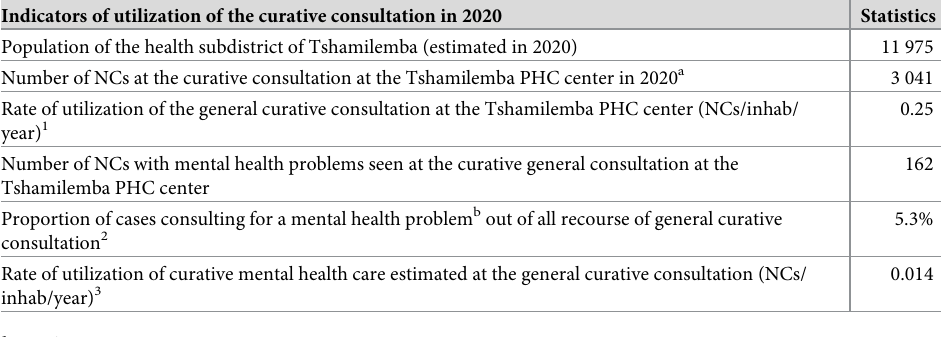
Table 3. Indicators of utilization of curative care at the Tshamilemba PHC center in the health district of Tshami- lemba in